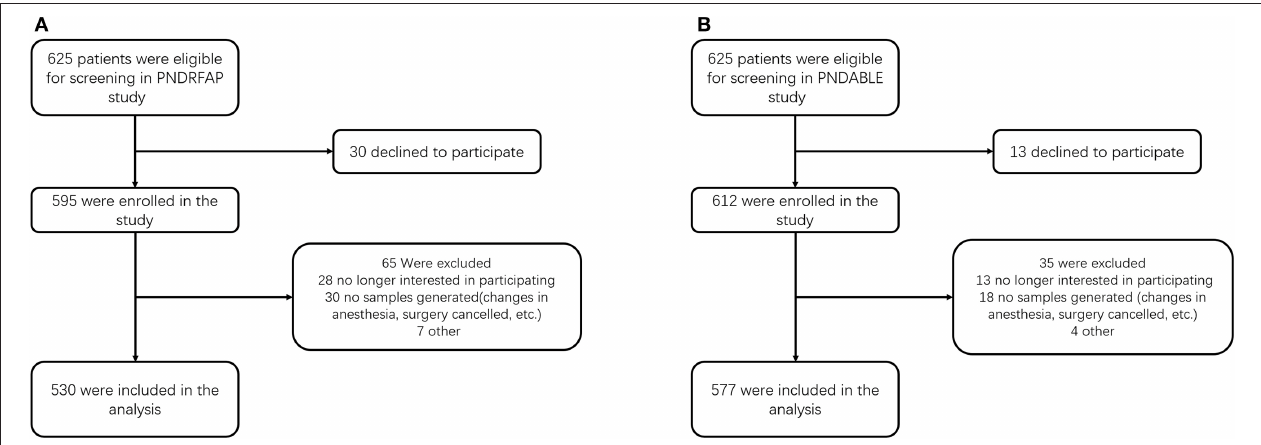
FIGURE 1 | Diagram of study design. (A) The Perioperative Neurocognitive Disorder Risk Factor and Prognosis (PNDRFAP) study. (B) The Perioperative Neurocognitive Disorder and Biomarker Lifestyle (PNDABLE)